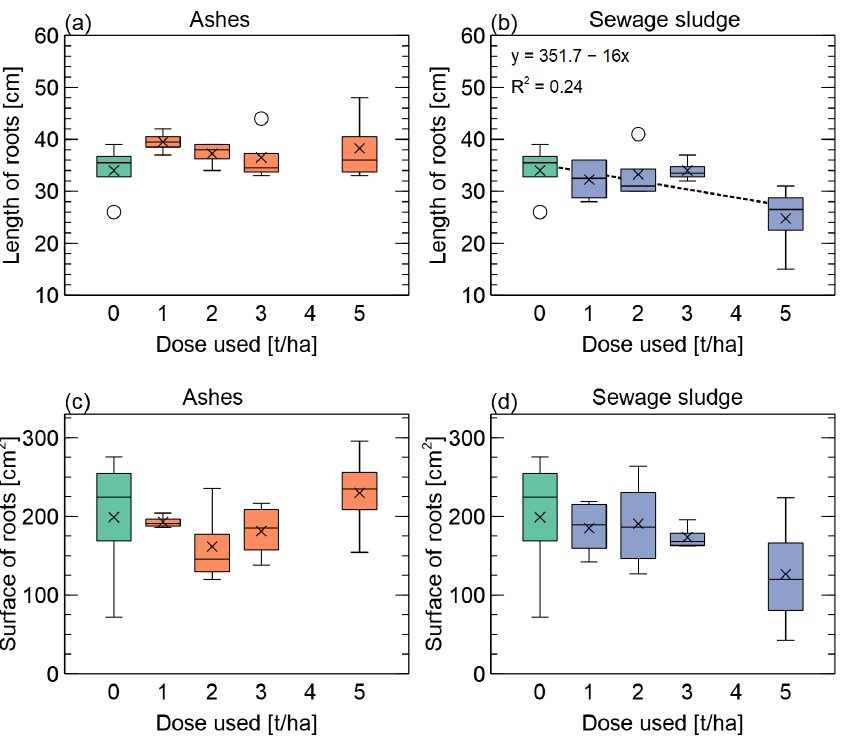
Figure 8. Roots length and surface area of Scots pine seedlings as a function of preparation dosage. Two studied variants of mixing with ash ( a , c ) and sewage sludge ( b , d ) are shown. The dashed line represents the linear regression fit of the data. The regression equation with the fitted parameters and the R 2 value of the model is shown in the sub-figure. The results of the regression analysis are presented only for the case where the regression parameters are statistically significant at p < 0.05. In the plot, boxes span from 1st to 3rd quantile, with the median indicated by a line, whiskers indicating 1.5 inter-quantile range, the × symbol mean value, and circles outlier observations.